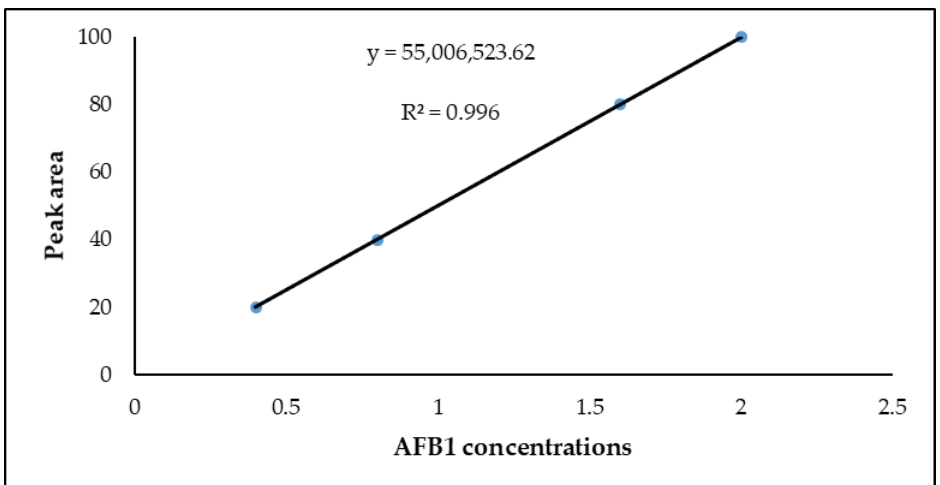
Figure 4. Standard curve for AFB 1 standard solution .